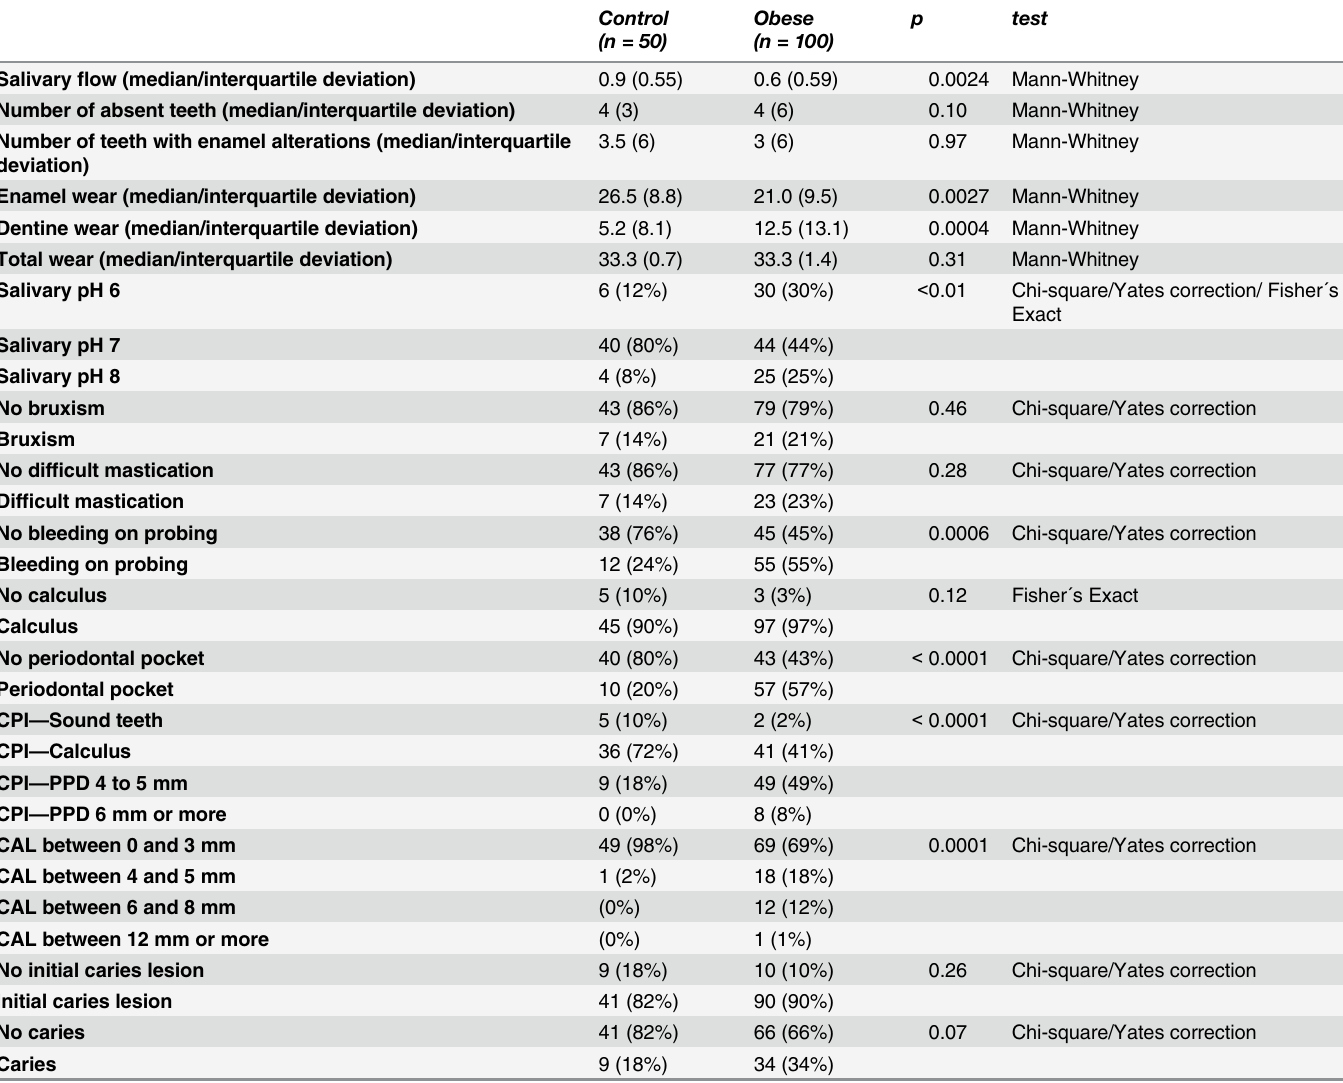
Table 2. Oral health conditions of both groups.